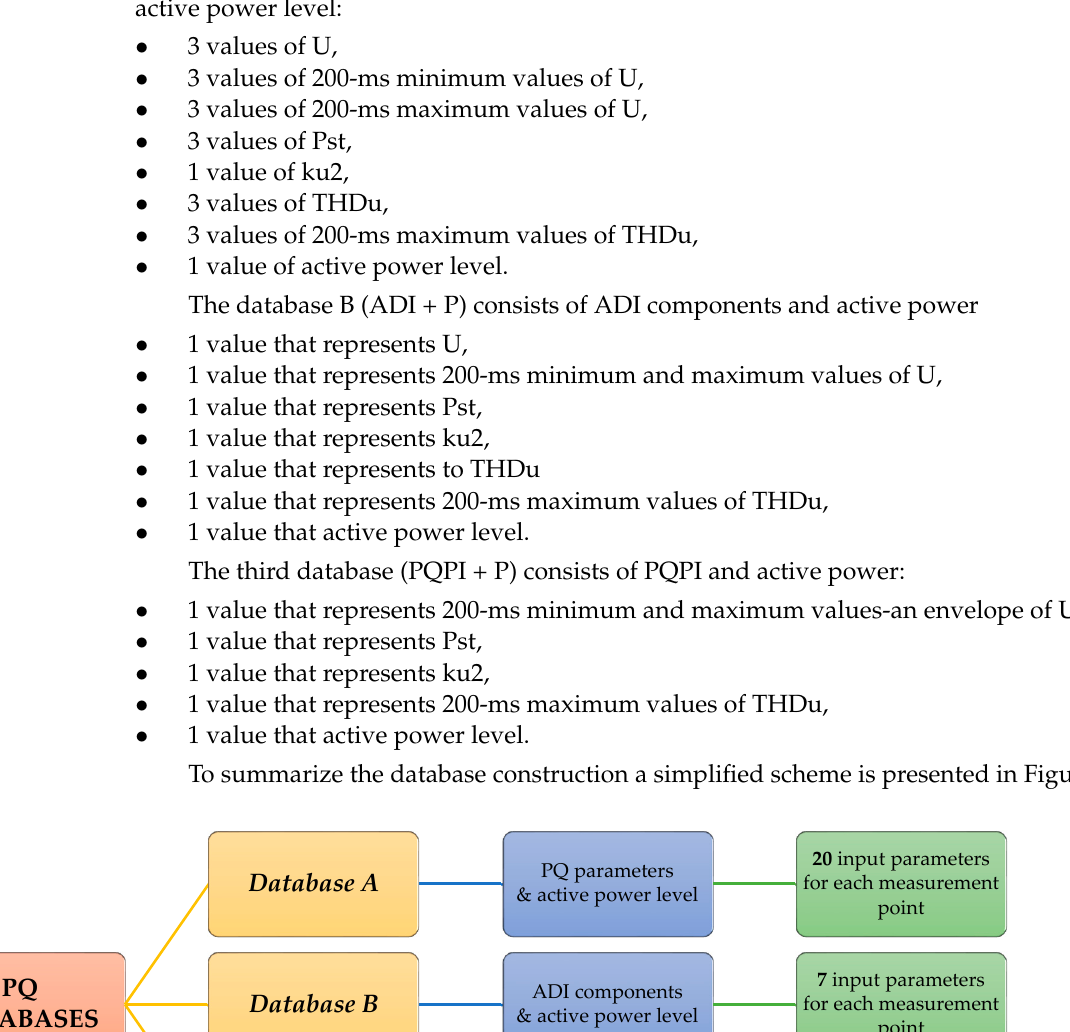
6 of 14 Table 1. Description of input databases. Database